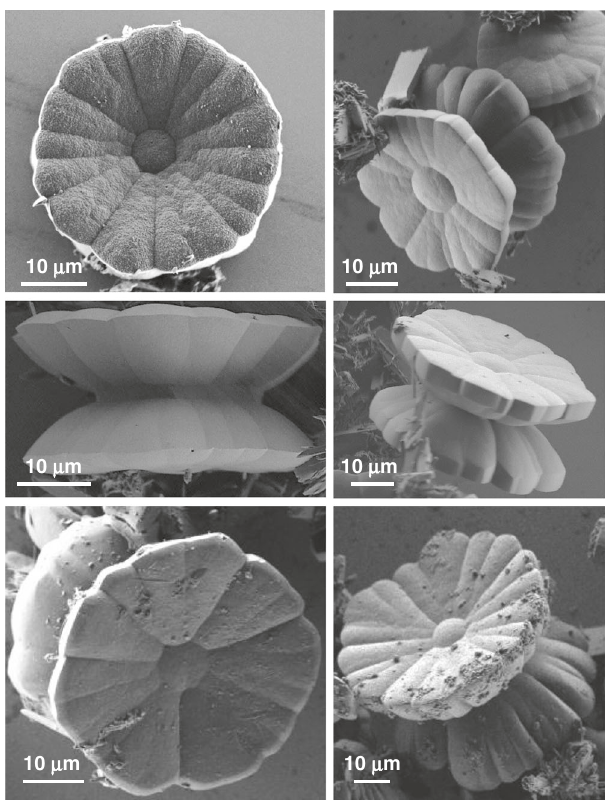
Fig. 2 Yo-yo-like single crystals. Scanning electron microscopy (SEM) images recorded after the solvothermal reaction followed by 2 days of aging of the sample at room